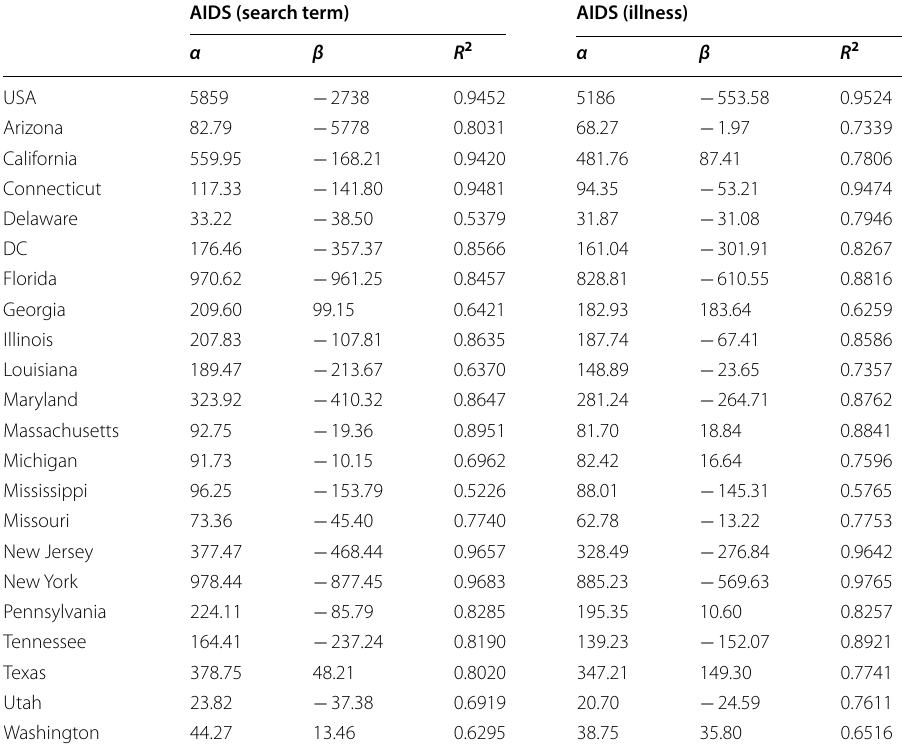
Table 7 Coefficients α and β , and R 2 for the estimated forecasting models for ‘AIDS Deaths’ AIDS (search term)